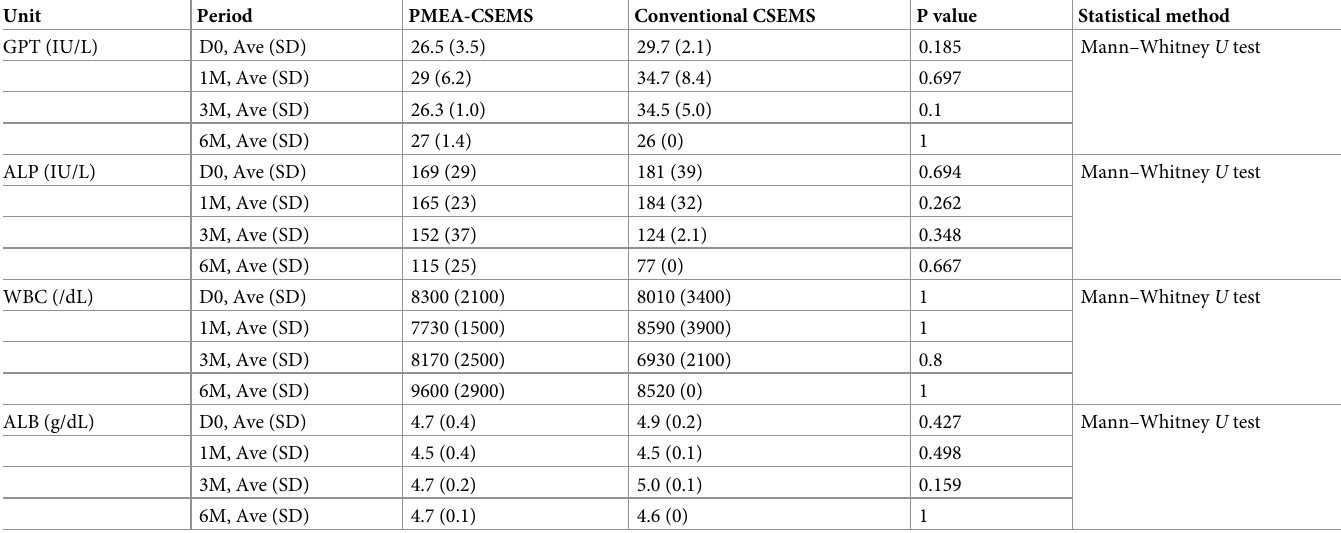
Table 2. Statistical analysis of the blood biochemical evaluation results for each follow-up period of the PMEA-CSEMS and conventional CSEMS groups. Unit